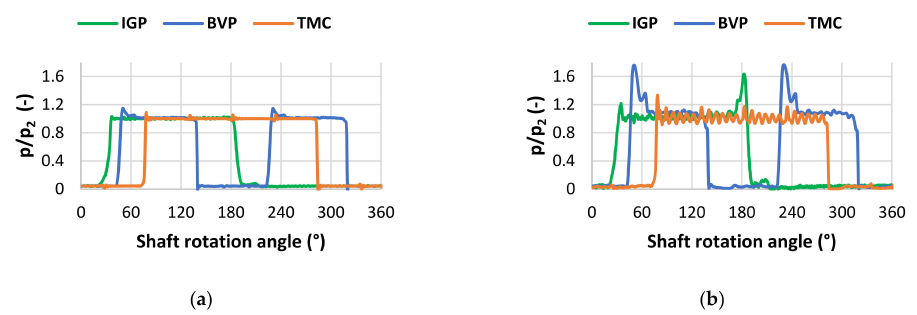
Figure 18. Comparison of the CFD data for the displacement chamber pressure profiles at p 2 = 22.5 bar pressure load and 20 ◦ C oil temperature for 1000 rpm ( a ) and 3000 rpm ( b ).